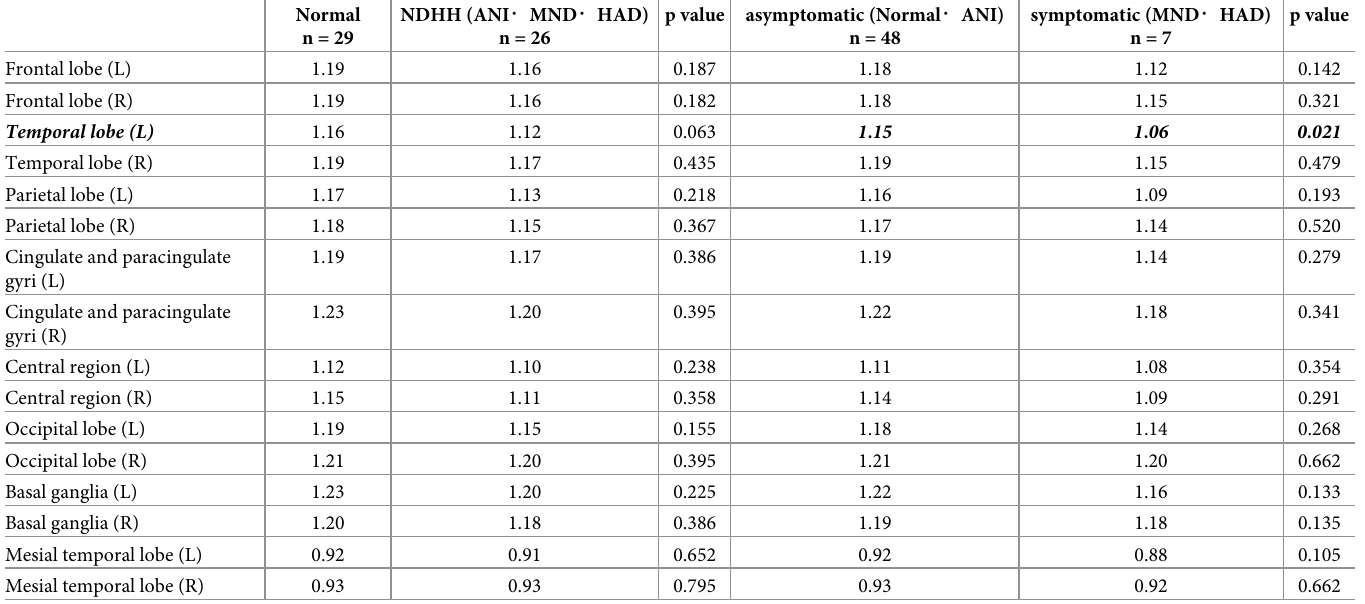
Table 5. Comparison of SUVr values between the normal group and the NDHH group and between asymptomatic and symptomatic groups among HIV-infected hemophilia patients. Normal n = 29